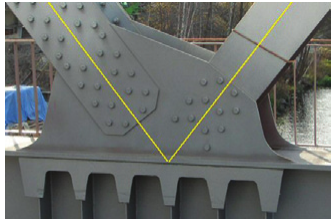
Fig. 4. Gusseted joint of bracing members and rigid flange